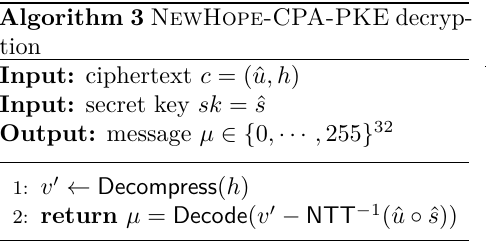
Algorithm 3 NewHope-CPA-PKE decryp-